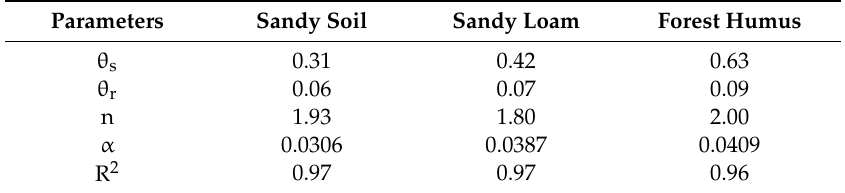
Table 1. The measured saturated ( θ s ) and residual ( θ r ) volumetric water content, and the empirical fitting coe ffi cients α , n for the water retention curves corresponding to van Genuchten model, and the correlation coe ffi cient (R 2 ) for the comparison between the measured and modeled water retention